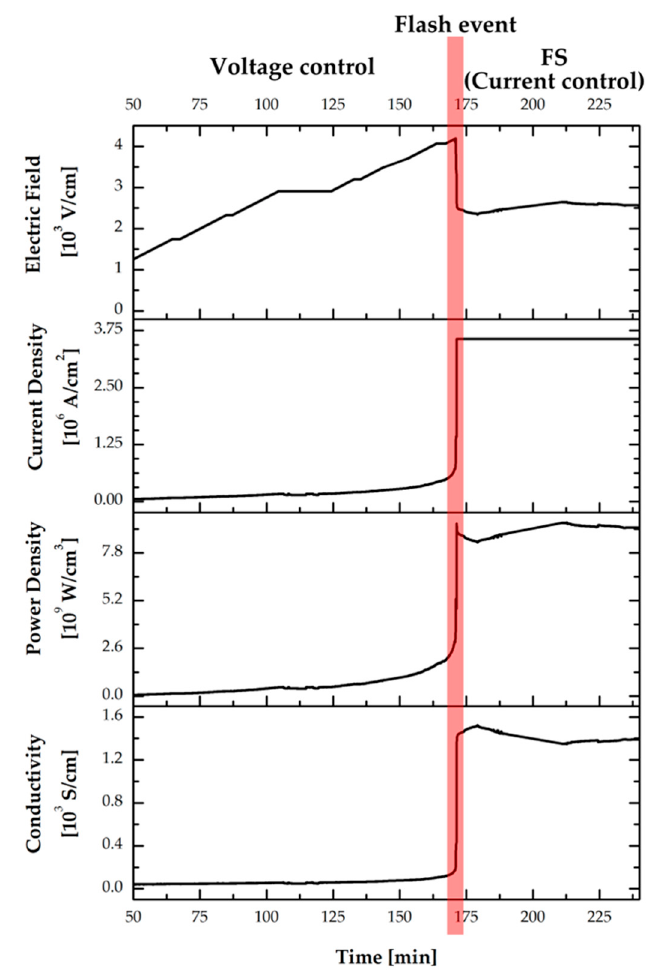
Figure 9. Time evolution of the electrical field, current density, power density and conductivity of the ZnO thin film during the in-situ TEM flash event. The specimen is under voltage control until the flash event occurs, when it is switched to current control and captured in the high conductivity flash event state. No additional heating was used during the experiment.